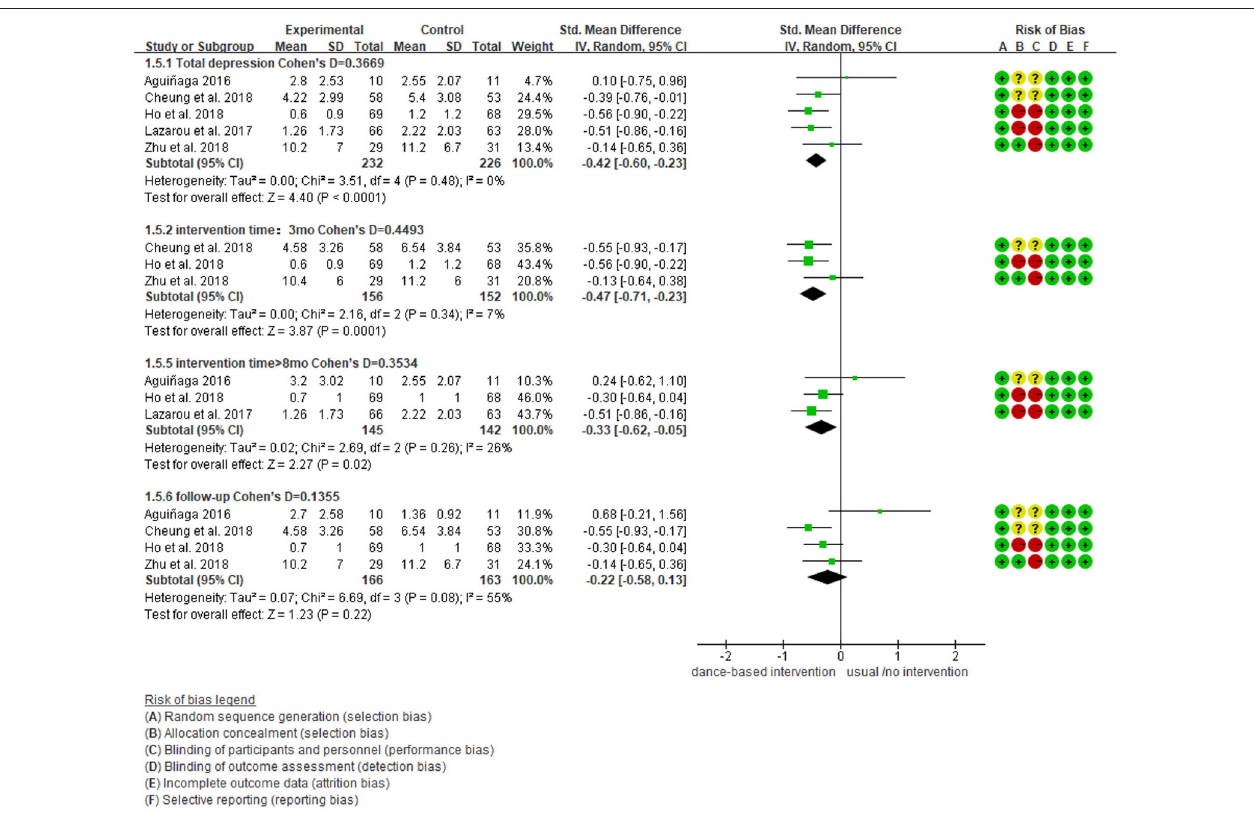
FIGURE 7 | Subgroup analyses of the intervention group vs. the control group on depression rating scores: Time points of data